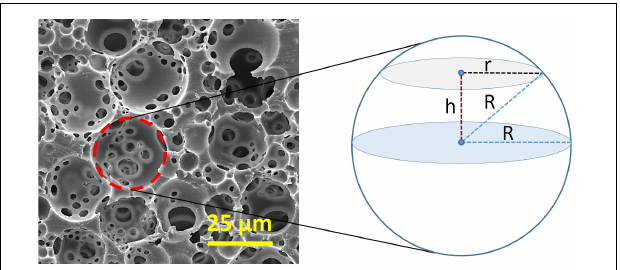
FIGURE 6 | Derivation of the statistical correction factor that is applied for adjusting the underestimation of the exact diameter of the pore size. R , an actual radius of the pore and r, the radius of the circular section at a distance of h from the centre of the pore.